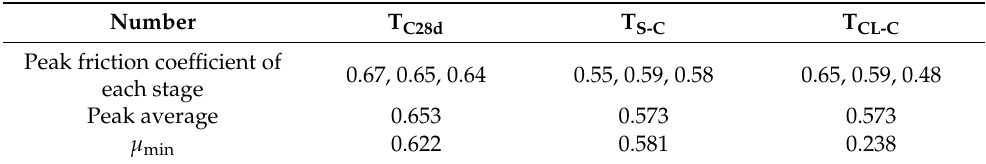
Table 3. Comparison of the peak and minimum interfacial friction coefficient at each stage.